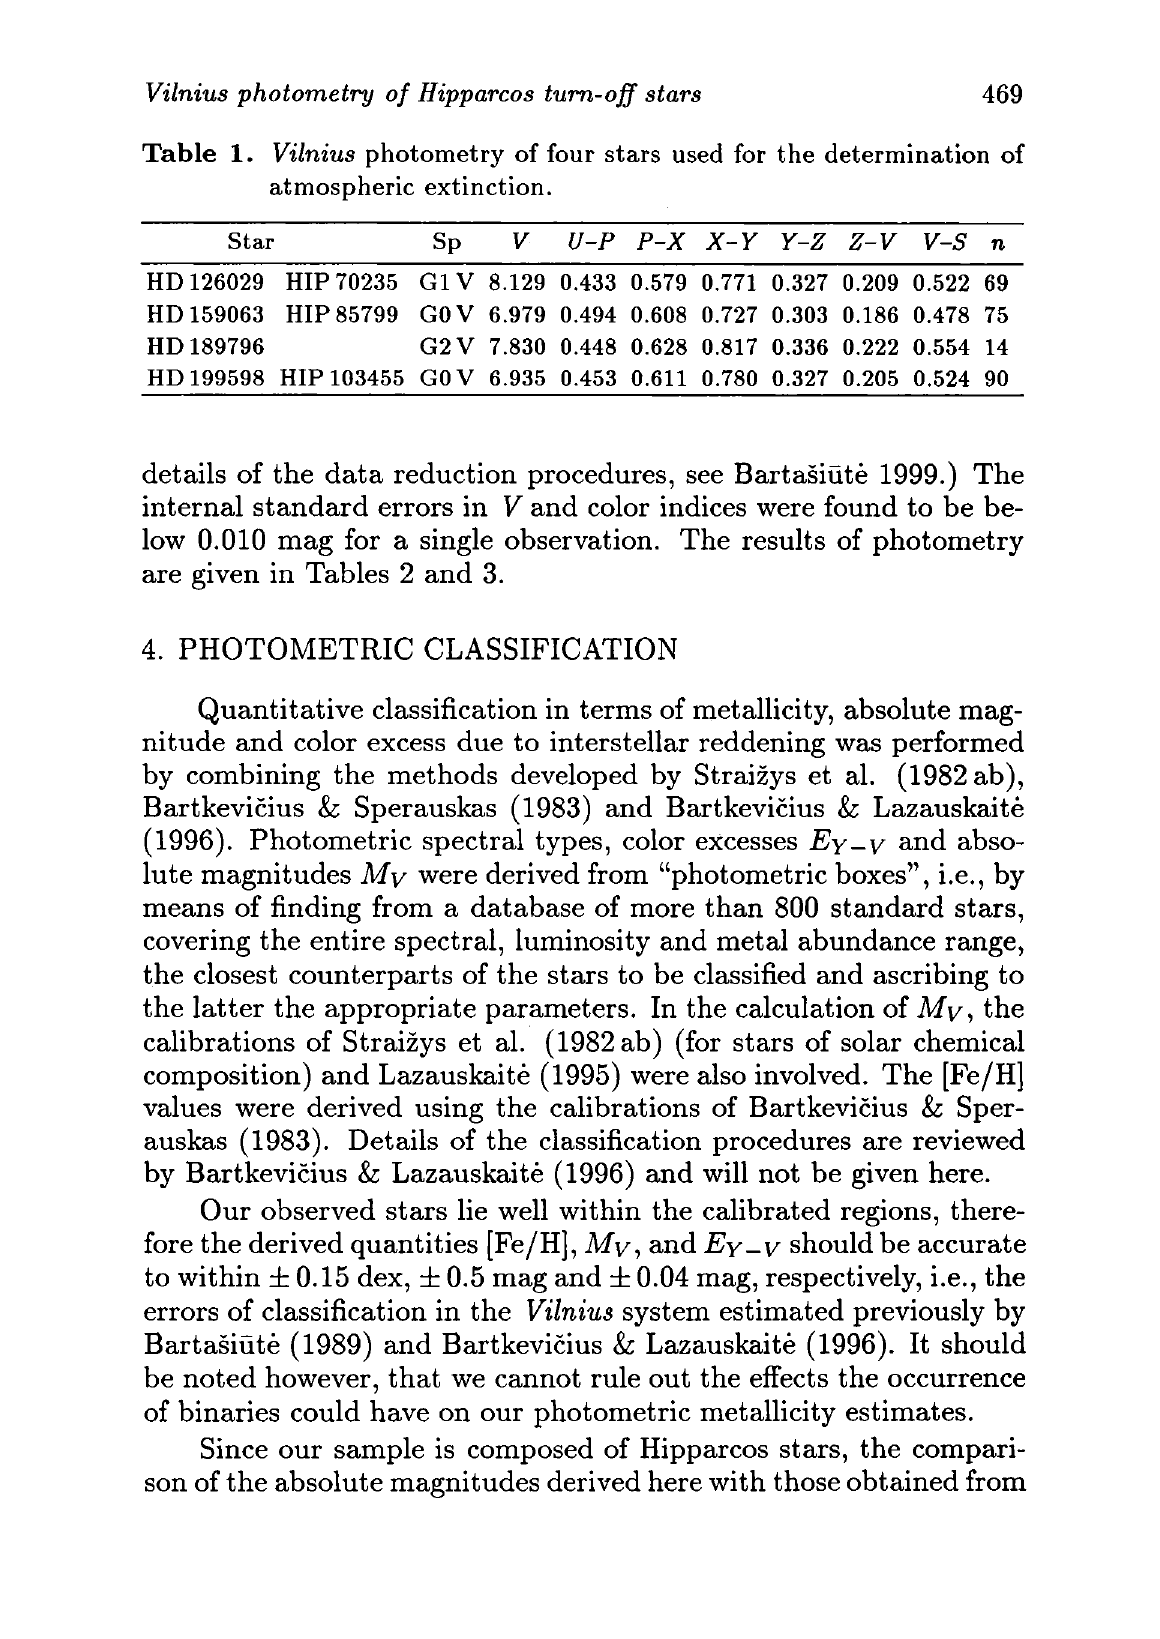
Table 1. Vilnius photometry of four stars used for the determination of atmospheric